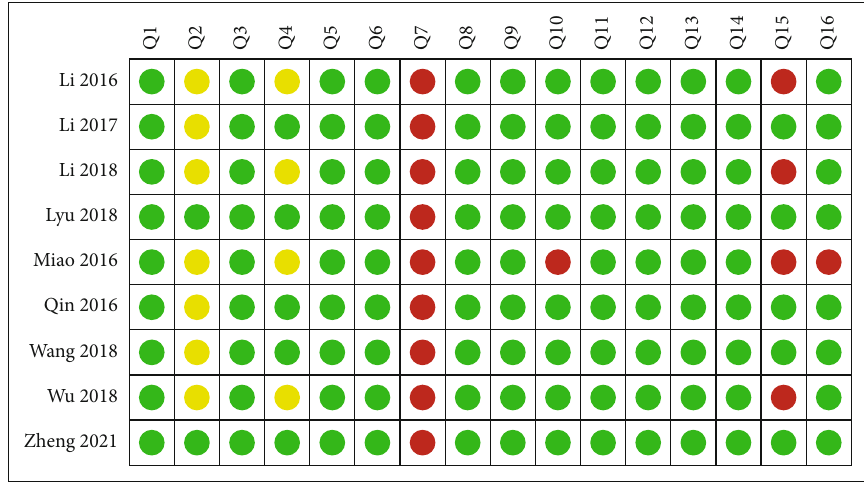
Figure 2: AMSTAR-2